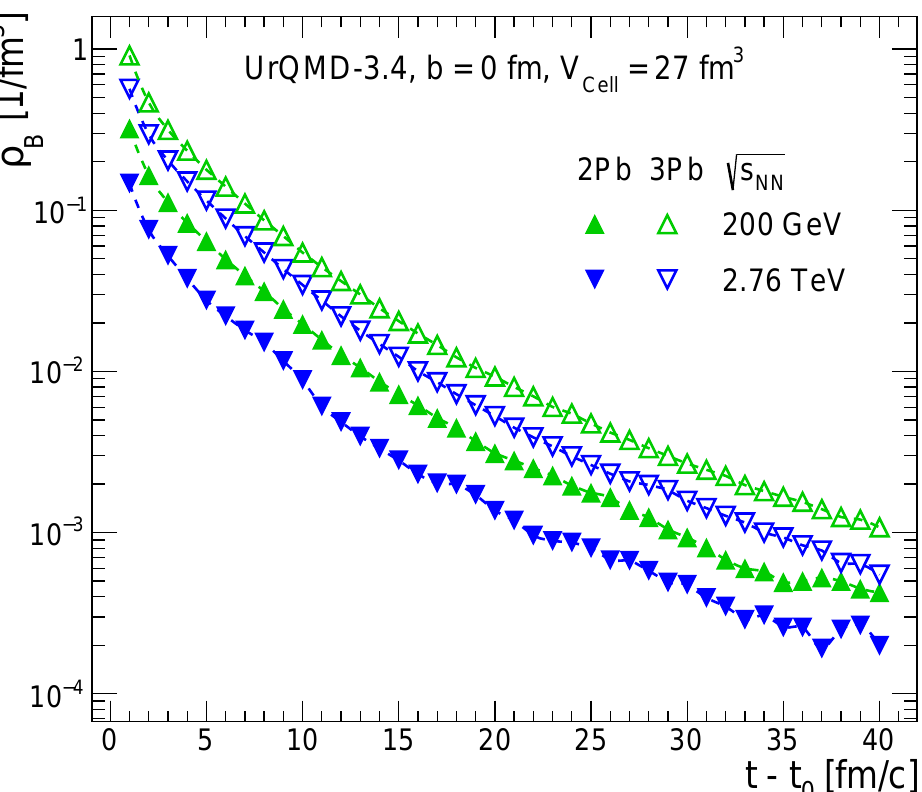
Figure 7. The time evolution of the central cell baryonic charge density of the volume 27 fm 3 during the process of ordinary BC collisions (filled symbols) and the TNC (empty symbols) for √ s NN = 200 GeV (triangles pointing upwards) and for downwards). The time t 0 is the moment at which the remnants of projectile nuclei have passed through the central